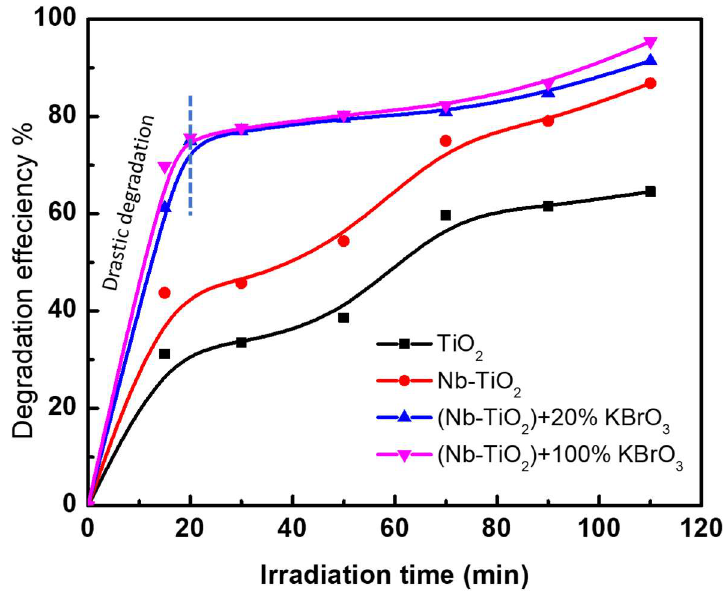
Figure 2. The photocatalytic efficiency of pure TiO 2 , Nb-TiO 2 , Nb-TiO 2 /20%KBrO 3, and Nb- TiO 2 /100%KBrO 3 .